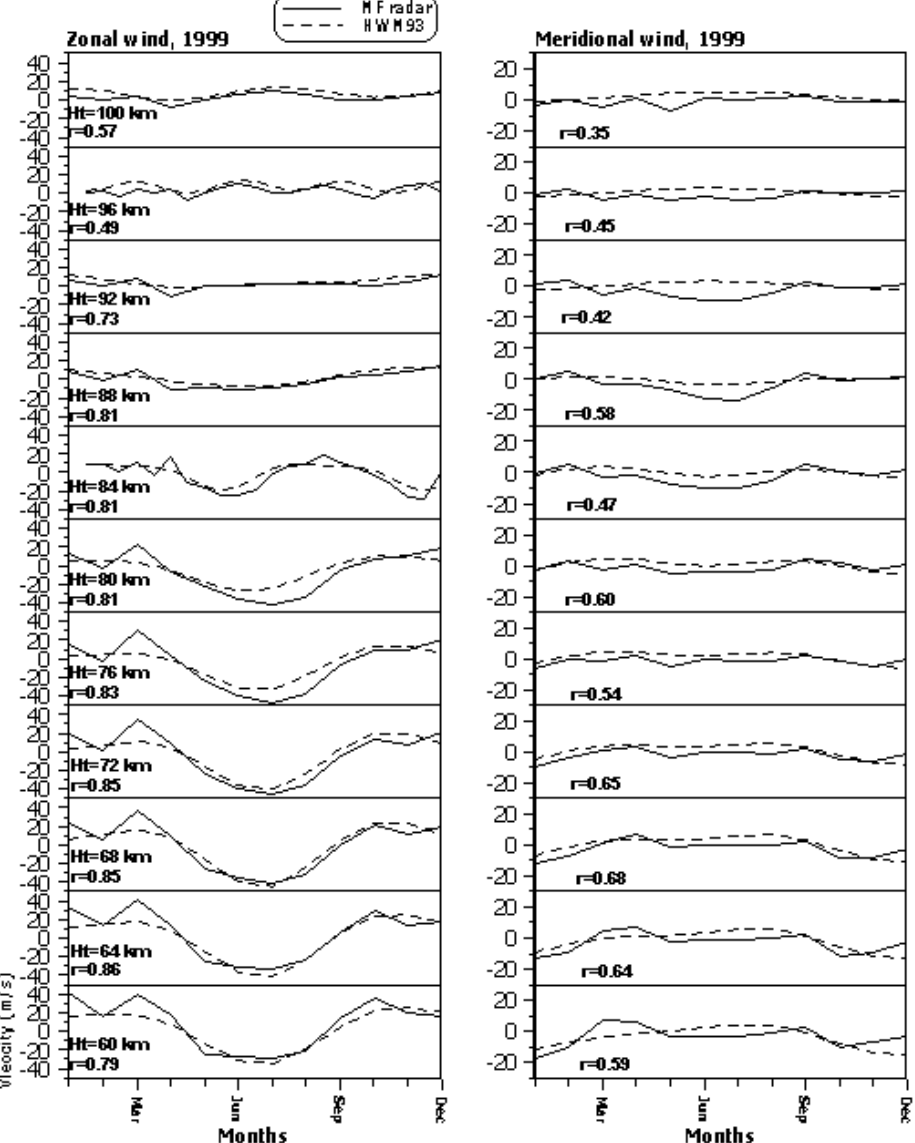
Fig. 4. The observed and modeled wind components for the year 1999. The data are given for 60–100km (4km interval). The correlation coefficient is given in each